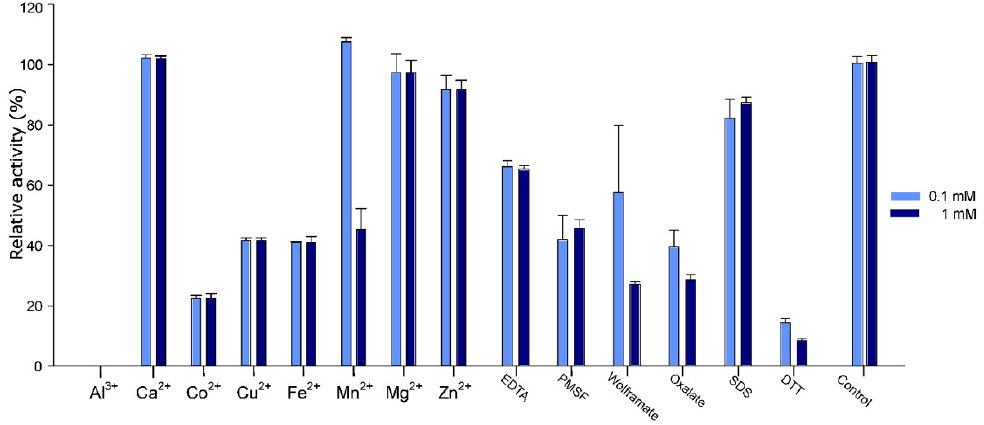
Figure 6. Effect of different concentrations of metal ions and inhibitors on the activity of Pho16B. All measurements were performed in triplicate and under optimal pH and temperature conditions for the enzyme. Specific activity values expressed as percentages of the control reactions (no additions) 8.2 U/mg for both concentrations.